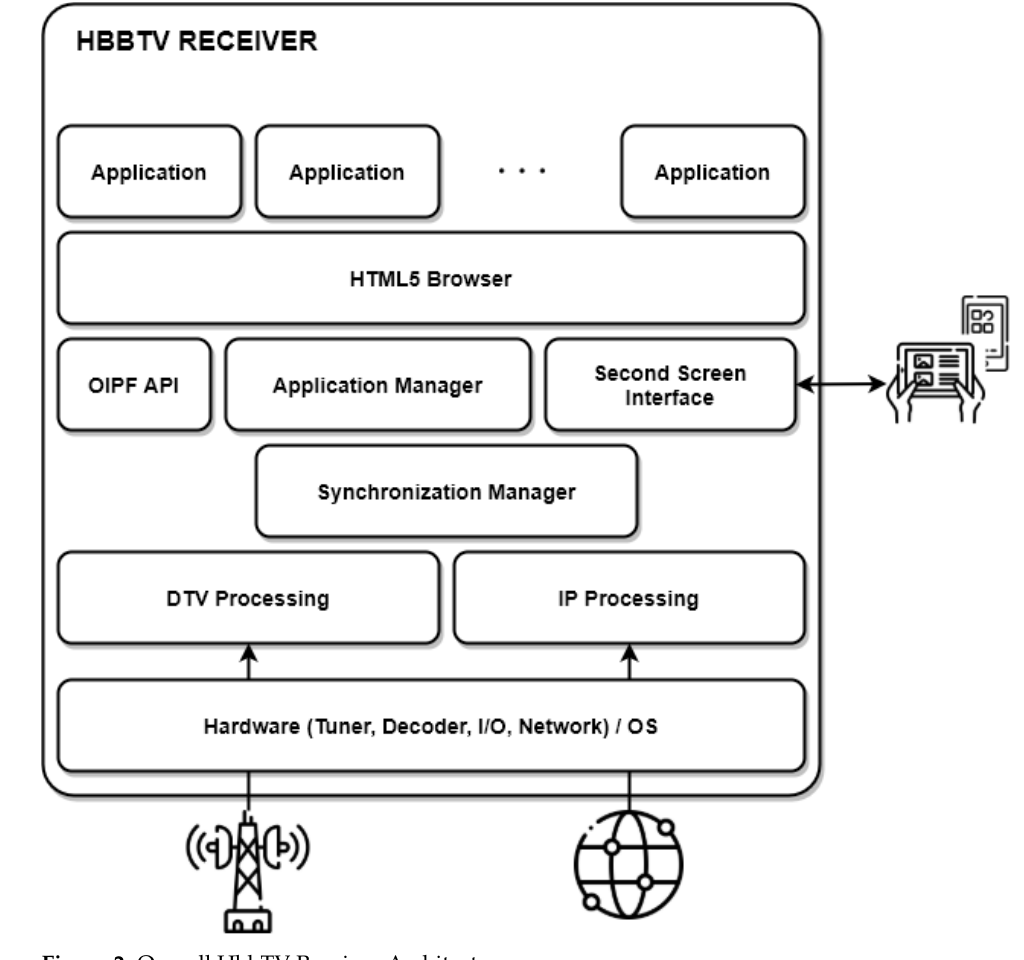
Figure 2. Overall HbbTV Receiver